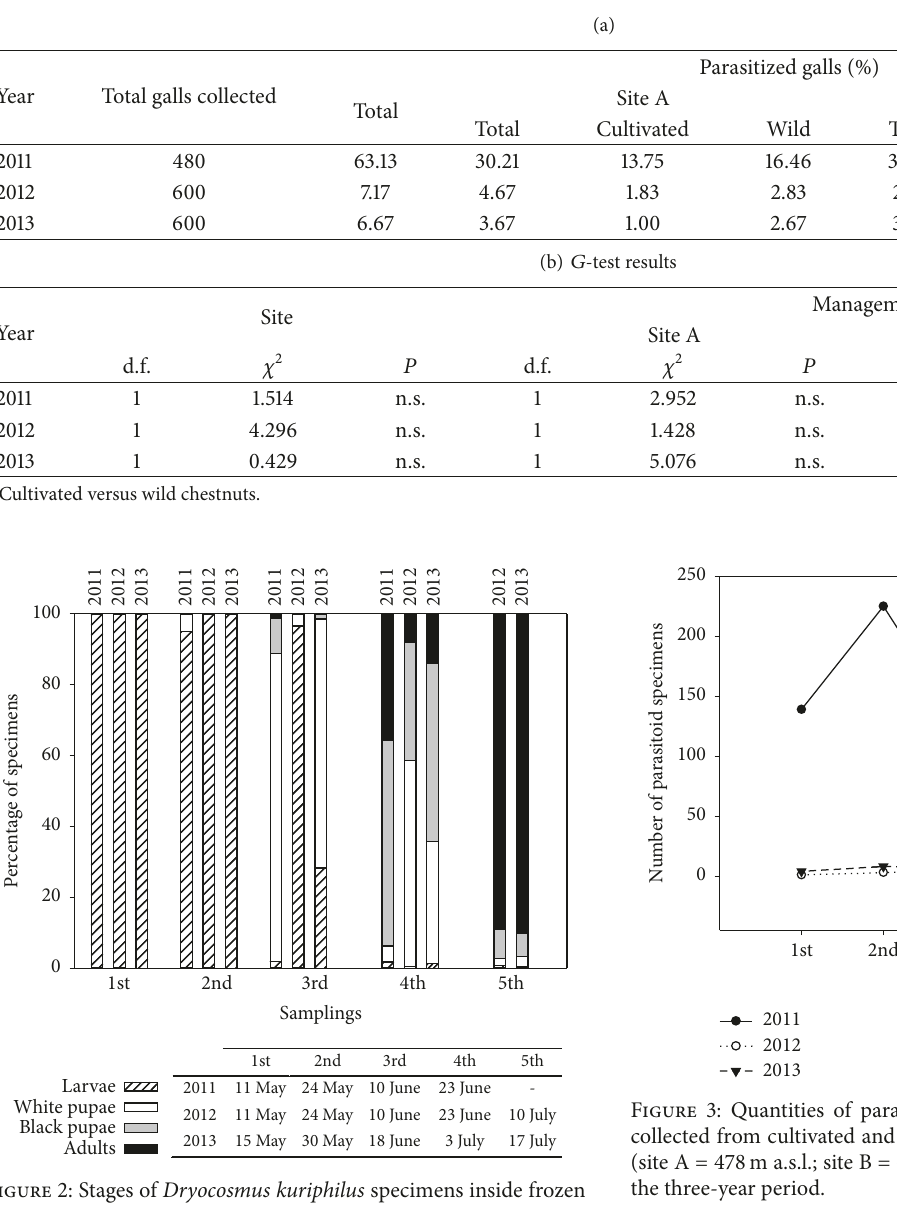
Table 1: Dryocosmus kuriphilus galls collected from cultivated and wild chestnuts in the two study sites (site A = 478 m a.s.l.; site B = 665 m